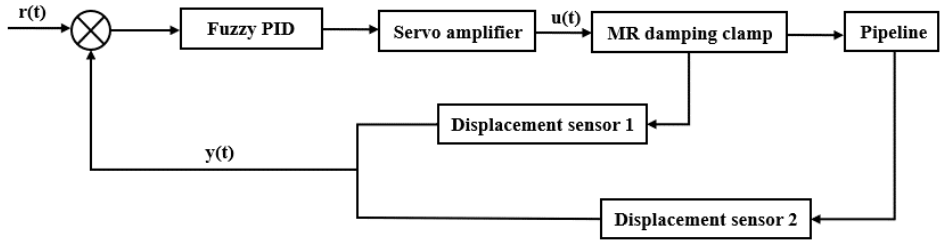
Figure 6. Automatic control system of the pipeline vibration.